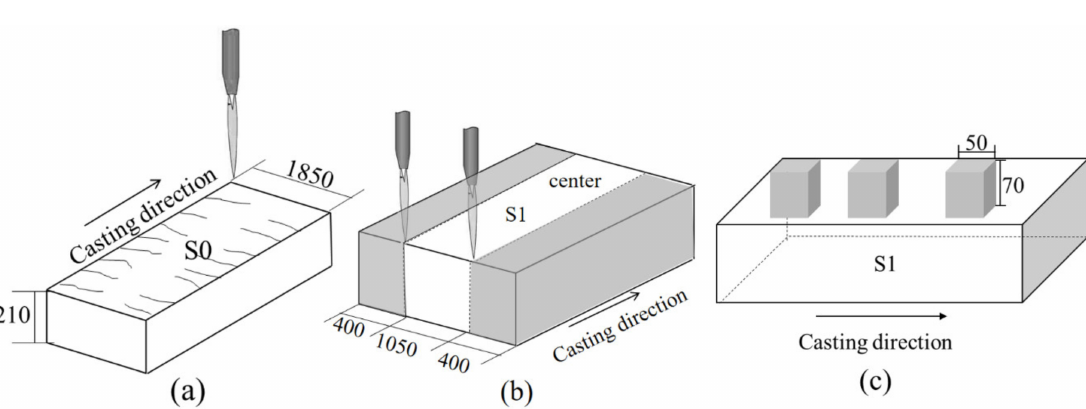
Figure 5. Sample lay-out from ( a ) continuously cast steel slab sectioned in ( b ) S1-center to take ( c ) smaller samples for oxidation tests under dry and water vapour